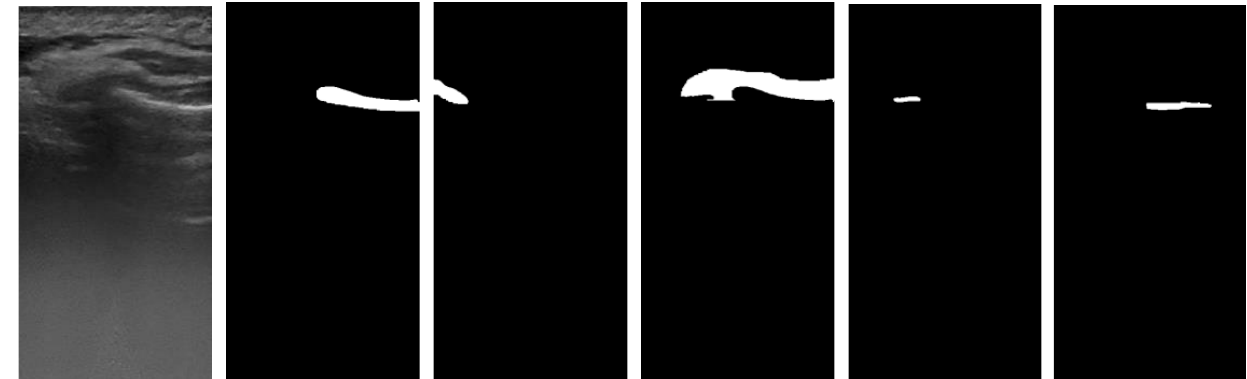
Figure 7. From left to right: original ultrasound image, bone, crown, gingiva, pocket, root.